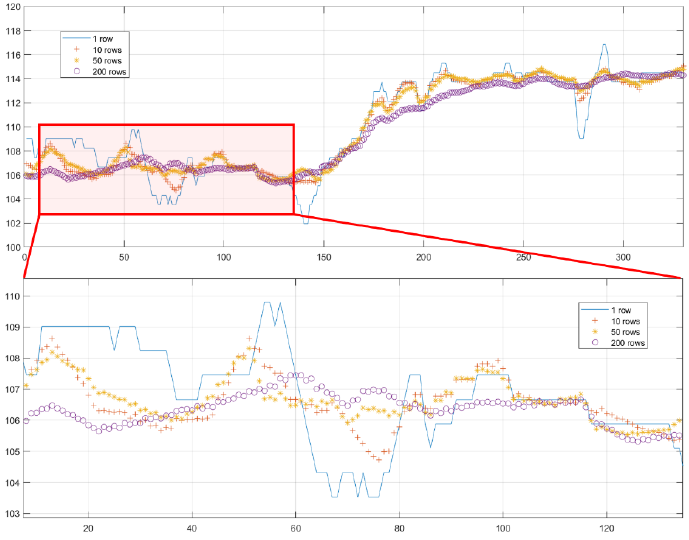
Figure 7. Number of different projection lines.